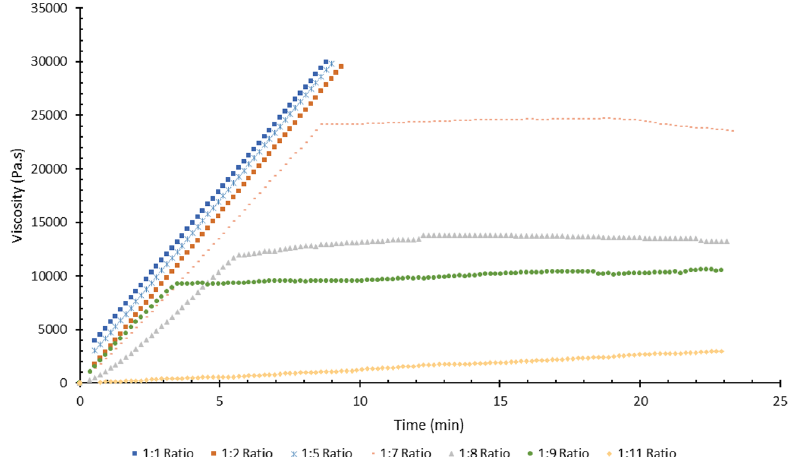
Fig. 9 Rheology at 0.02